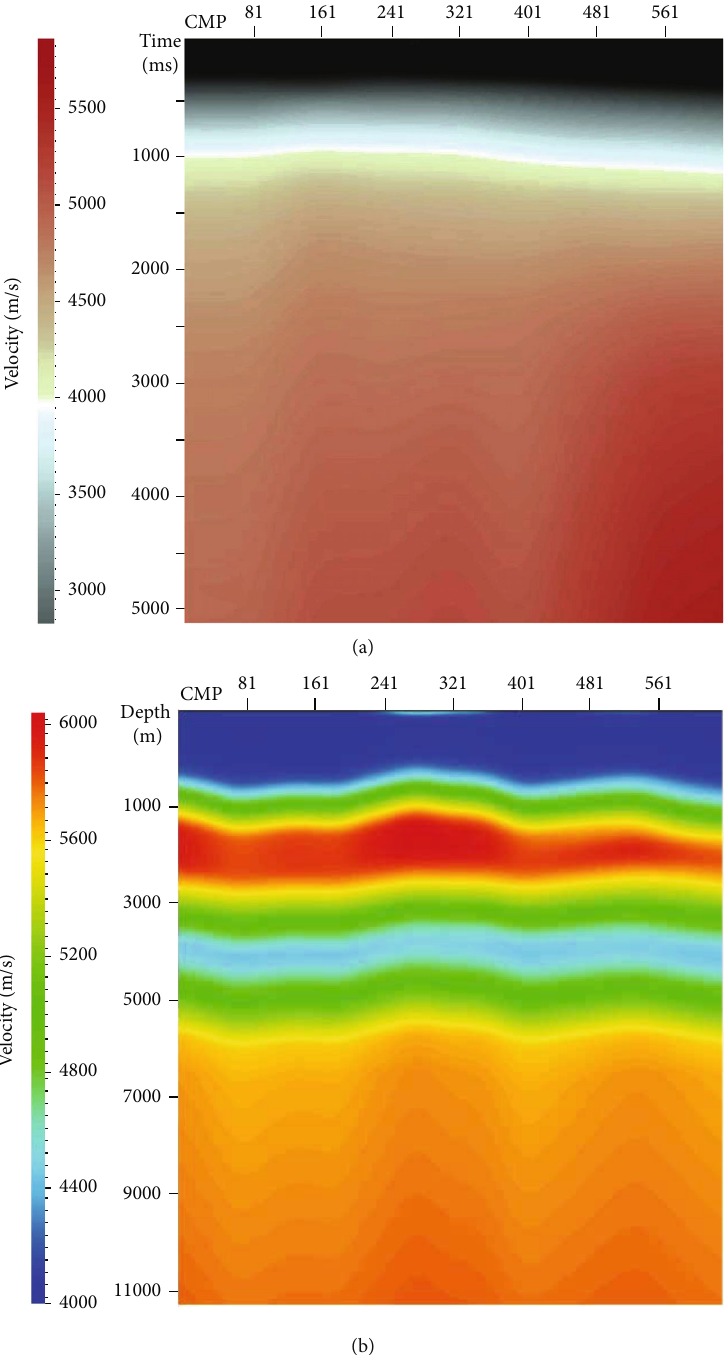
Figure 16: The fi nal velocity model. (a) RMS velocity of PSTM. (b) Interval velocity of PSDM